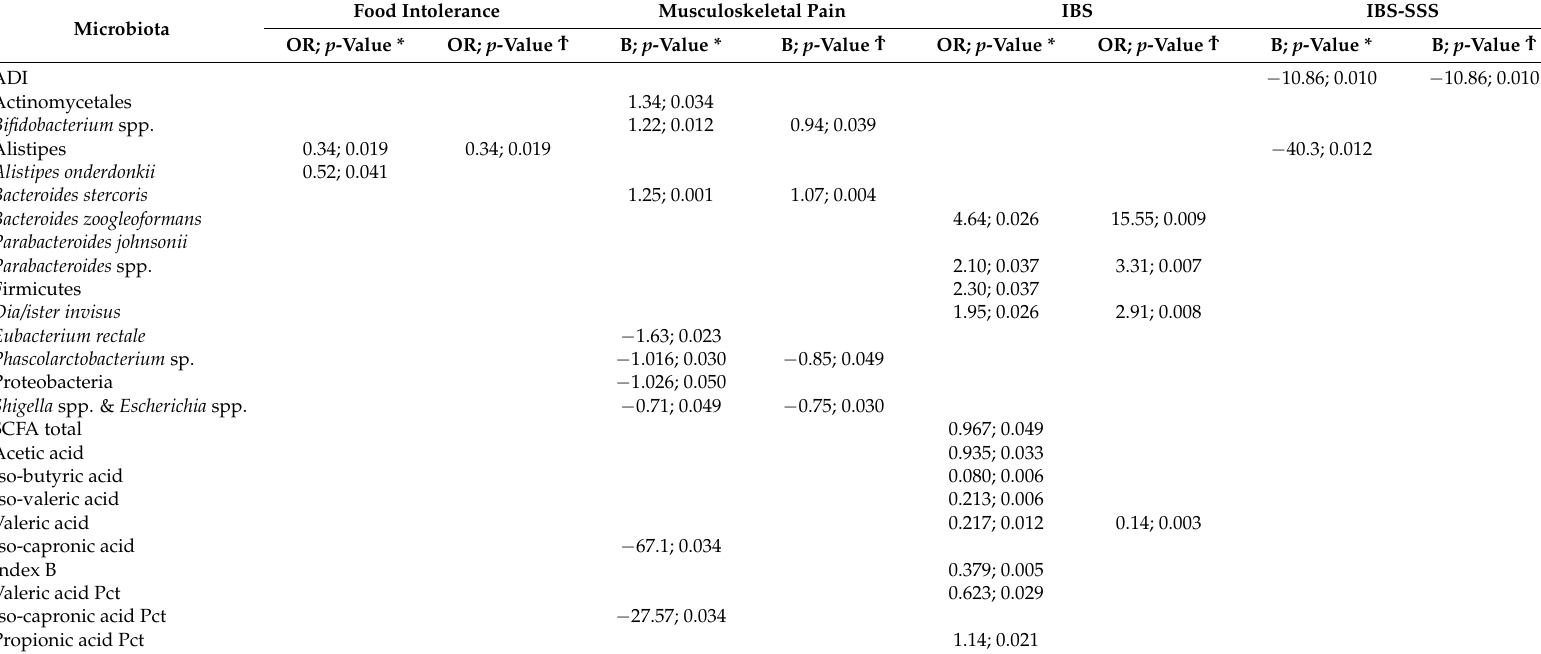
Table 4. The significant associations between the functional somatic disorders and the faecal microbiota and SCFA. Regression analyses with the functional somatic Table 3. The significant associations between the psychological disorders and the faecal microbiota Table 3. The significant associations between the psychological disorders and the faecal microbiota Table 3. The significant associations between the psychological disorders and the faecal microbiota disorders as dependent variables. Table 3. The significant associations between the psychological disorders and the faecal microbiota and SCFA. Regression analyses with the psychological variables as dependent variables. and SCFA. Regression analyses with the psychological variables as dependent variables. and SCFA. Regression analyses with the psychological variables as dependent variables. and SCFA. Regression analyses with the psychological variables as dependent variables.